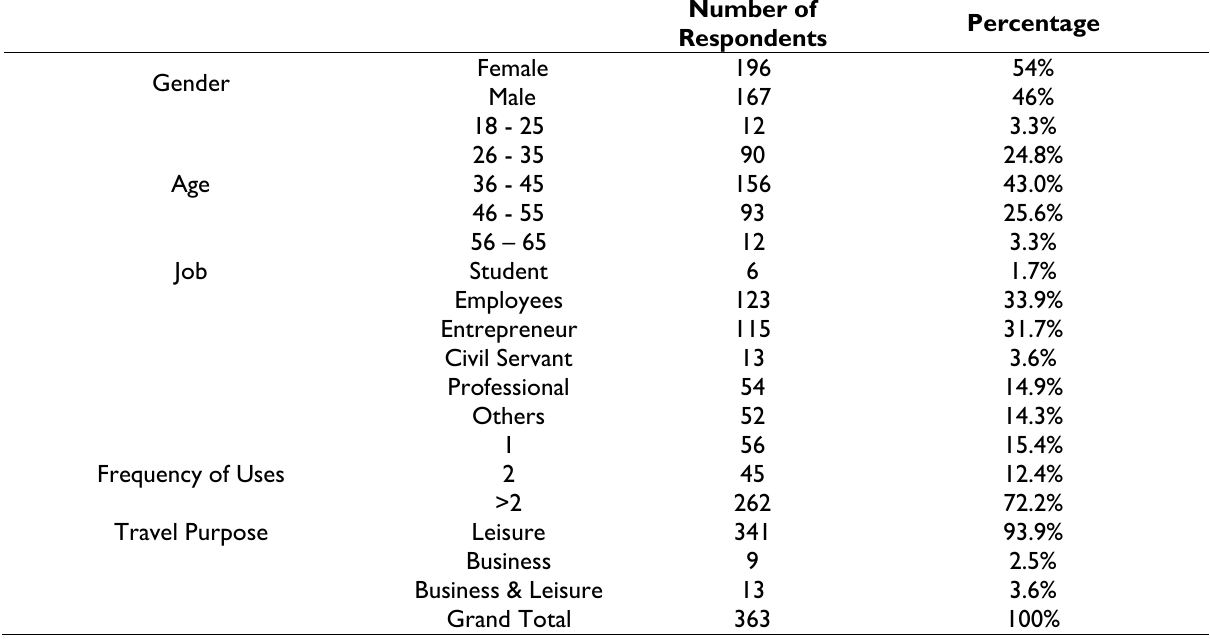
Table 2. Characteristics of